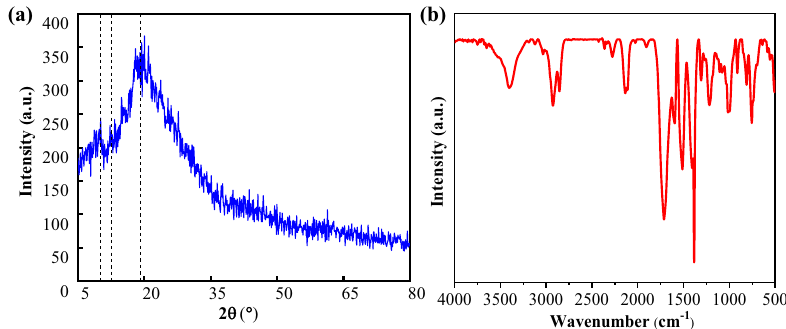
Figure 4: ( a ) XRD patterns and ( b ) Infrared spectrum of the